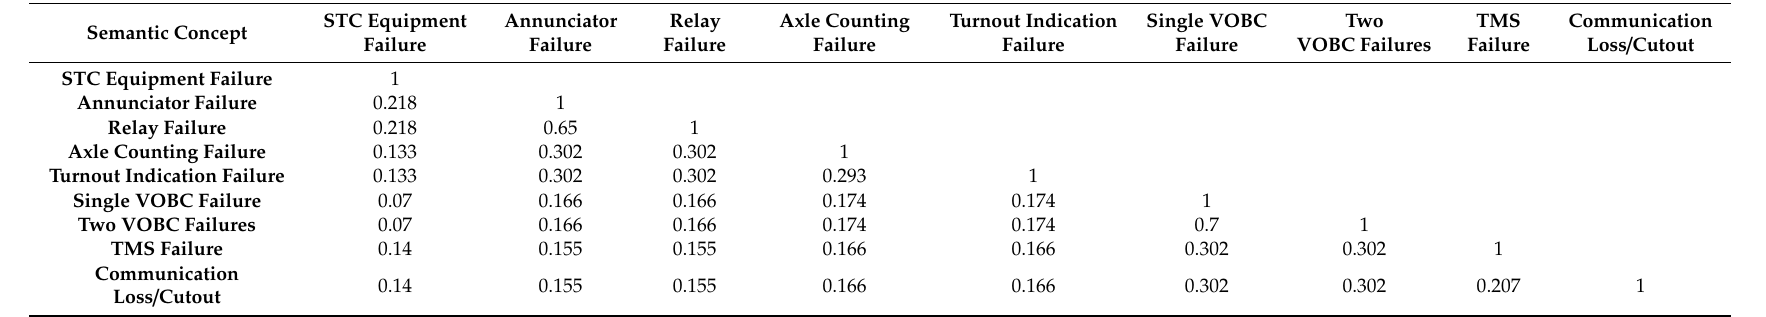
Table 4. Similarity between the semantic concepts of partial signal